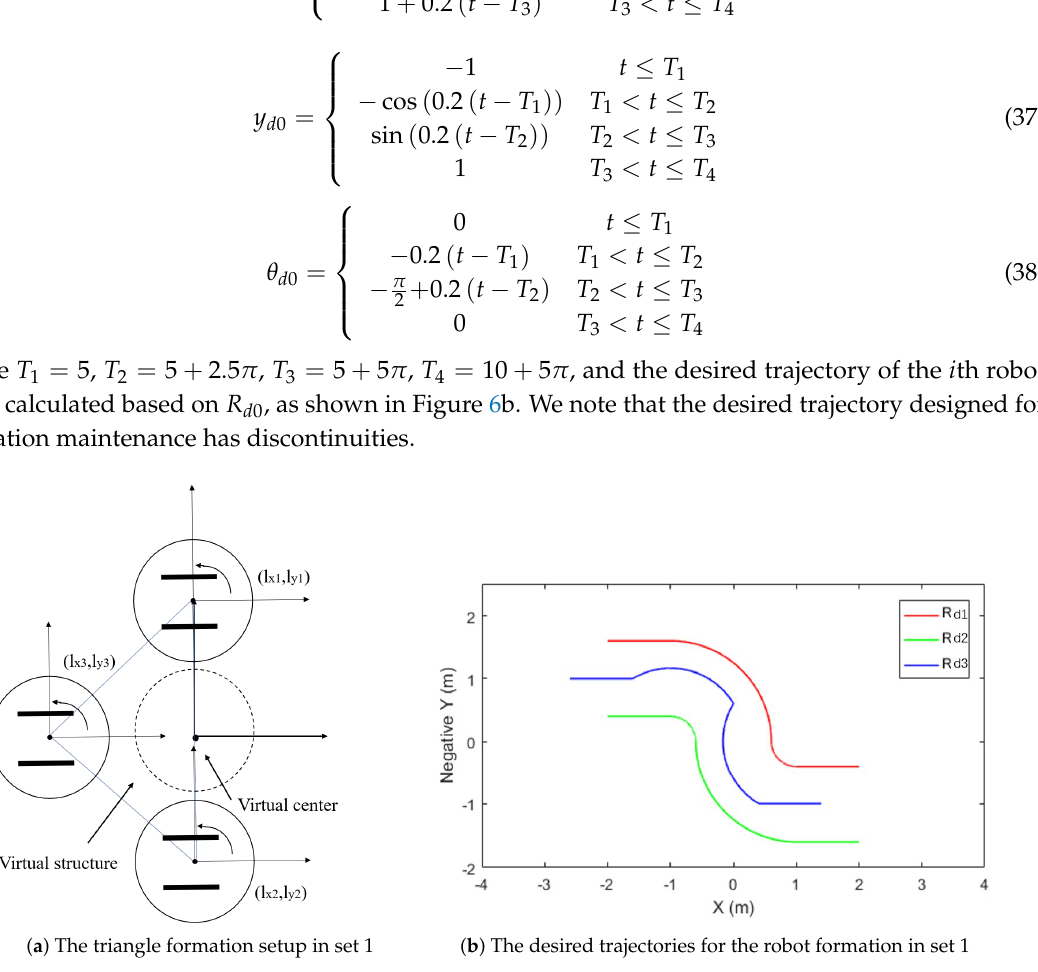
Figure 6. The triangle formation setup and desired trajectories for the robot formation in set